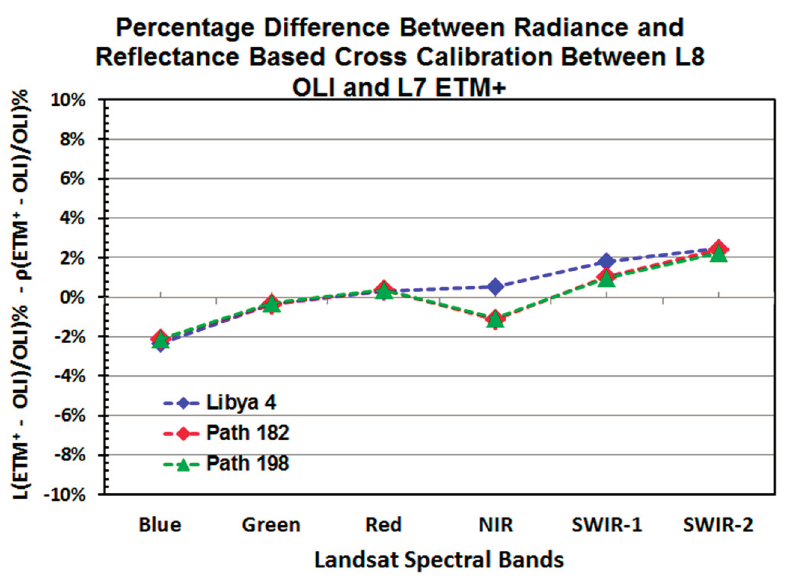
Figure 10. Comparison between reflectance and radiance-based